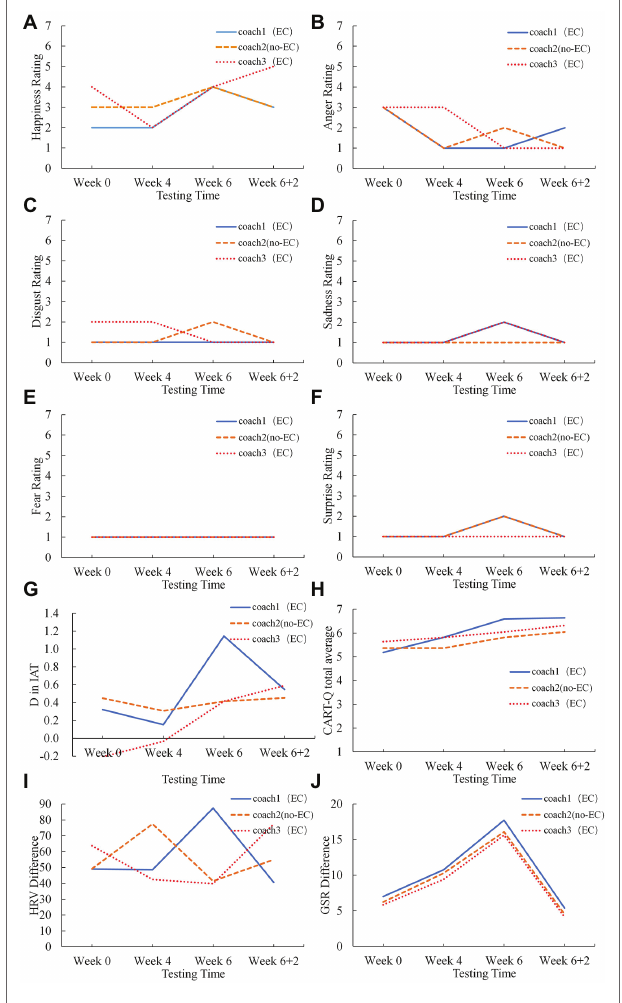
FIGURE 2 | The variation of Athlete 1’s (A–F) the emotion ratings (happiness, anger, disgust, sadness, fear, surprise), (G) the D score in IAT, (H) the CART-Q scores, (I) the HRV, and (J) the GSR with time for the coaches with and without